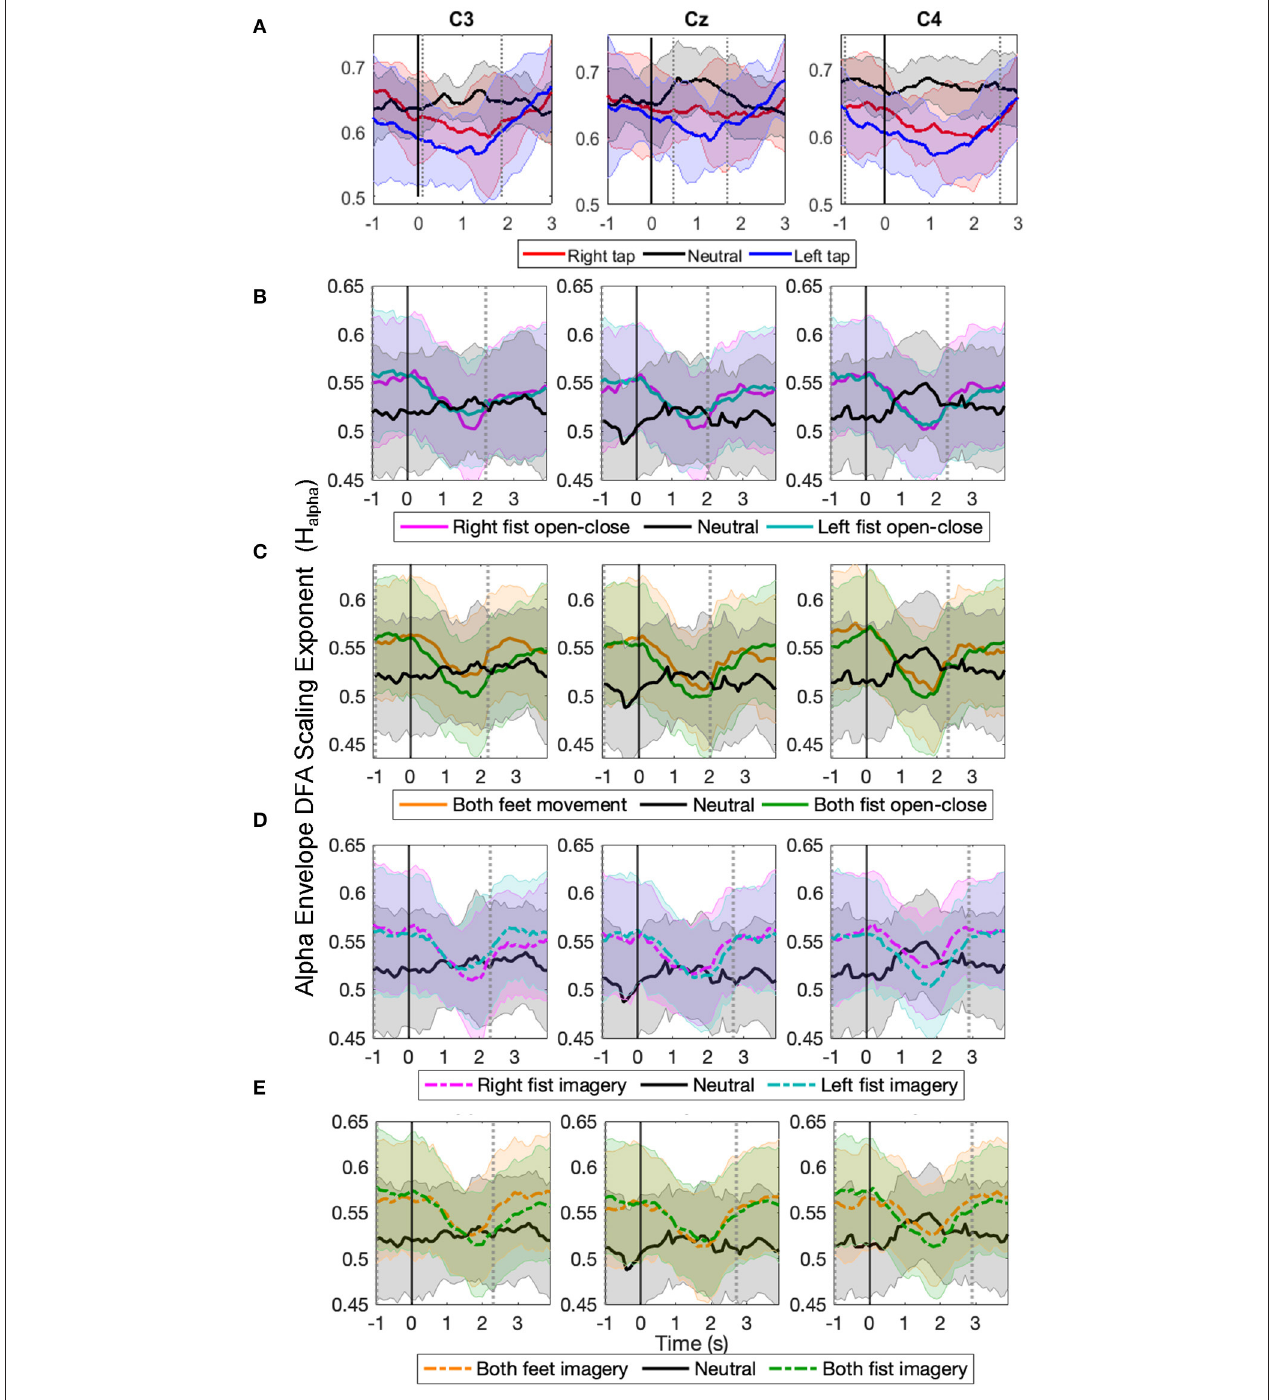
FIGURE 3 | The time evolution of grand average detrended fluctuation analysis (DFA) scaling exponents in the envelope of alpha oscillations of stitched electroencephalography (EEG) ( H alpha ) in C3, Cz, and C4 during different movement and motor imagery tasks. The progression of the grand average of alpha oscillation amplitude envelope DFA scaling exponent H alpha of all participants during (A) single asynchronous right (red) and left (blue) finger tap and resting state (black), (B) continuous right (magenta) and left (cyan) fist open-close movement, (C) continuous both feet (orange) and both fist (green) open-close movement, (D) motor imagery of continuous right (dashed magenta) and left (dashed cyan) fist open-close, (E) motor imagery of continuous both feet (dashed orange) and both fist (dashed green) open-close. Shaded areas show the standard deviation. Solid vertical line at 0 s marks finger tap onset in (A) and motor task cue in (B–E) . Dotted gray vertical lines show the period in which H alpha of motor task trials is significantly different ( p < 0.05, Mann–Whitney U -test) from that of resting state trials. The H alpha shows clear decrease during all motor tasks.